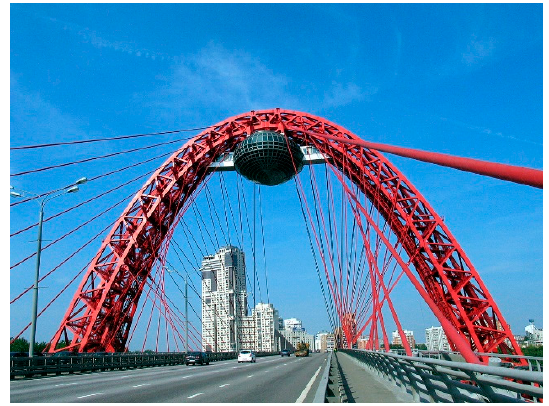
Figure 13. Zhivopisny Bridge (photo: Catherine, Wikimedia Commons).